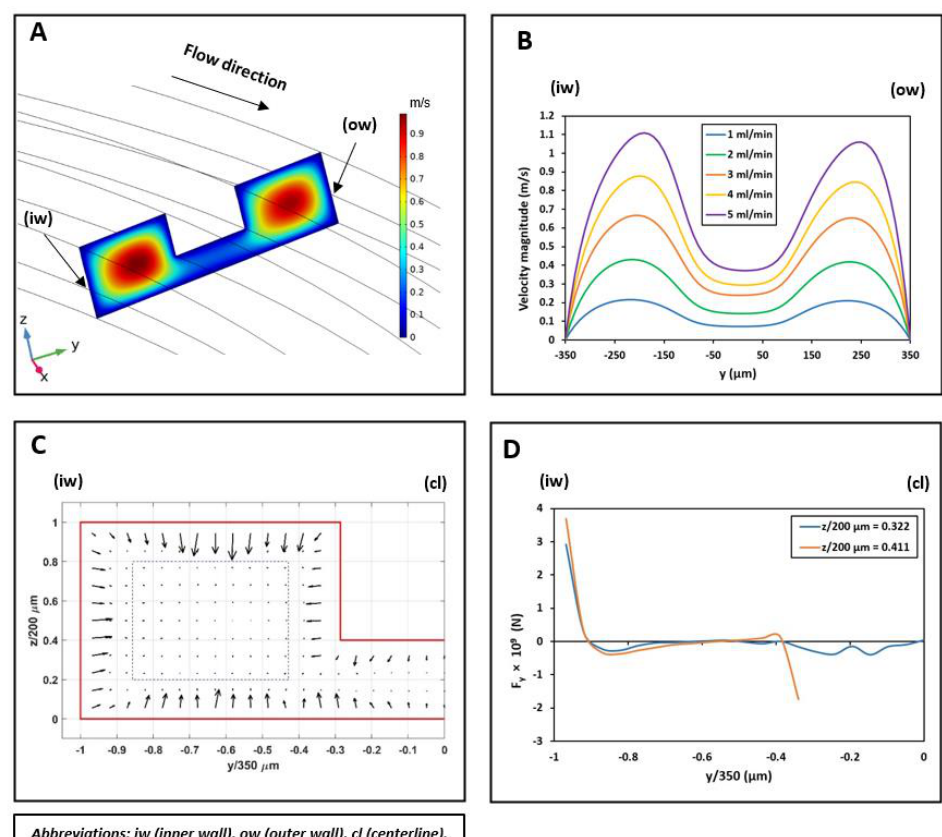
Figure 7. ( A ) Contour of velocity magnitude in the spiral microchannel at the second loop at x = 0 with an inlet flow rate of 3 mL/min. ( B ) Velocity magnitude profile with the change in inlet flow rates at z = 40 µm (z = 0 indicates the bottom wall of the microchannel and y = 0 indicates the centerline of the microchannel cross-section (cl), this difference in the maximum velocity magnitude results in the streamlines being directed from the inner microchannel wall (iw) toward the outer microchannel wall (ow). ( C ) The calculated inertial force field acting on a 10 µm particle in the inner section of the spiral microchannel with an inlet flow rate of 5 mL/min. Equilibrium positions are shown as blue dashed lines in the microchannel cross-section. ( D ) The inertial force applying to a 10 µm particle alongside y-direction at z = 64.4 µm (z/200 µm = 0.322) and z = 82.2 µm (z/200 µm = 0.411). As can be seen, the inertial force at the beginning of the passway is much lower than the wall-induced inertial force. The Dean drag force can overcome this inertial force, therefore, allowing the particles smaller than 10 µm to move toward the outer section of the spiral microchannel.